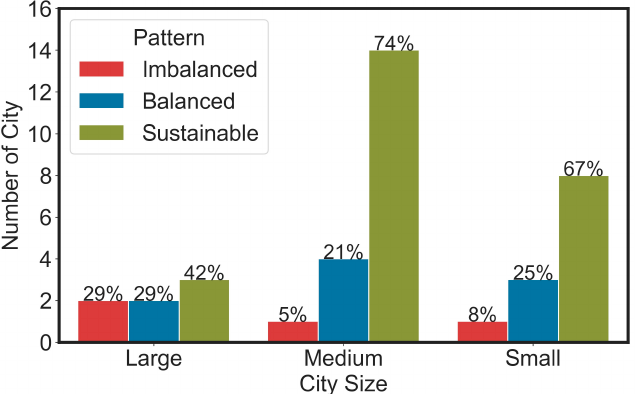
Figure 9. Statistics of road distribution patterns in cities of different sizes.